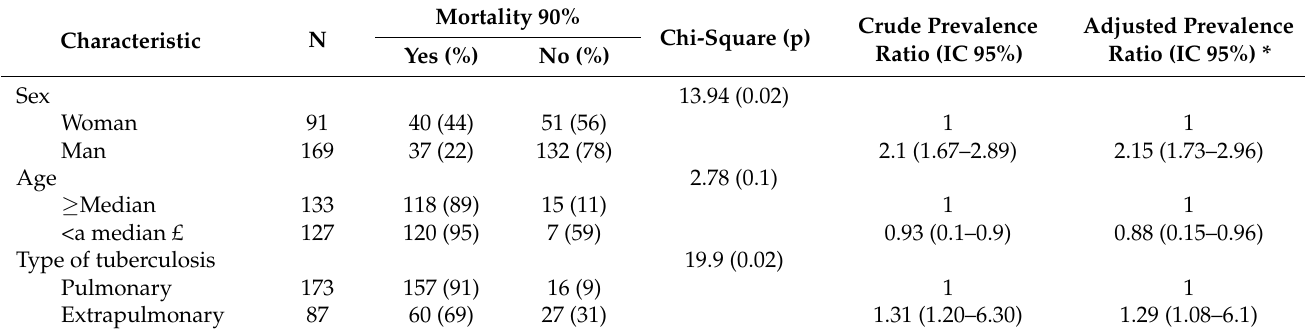
Table A2. Description of variables and their association with